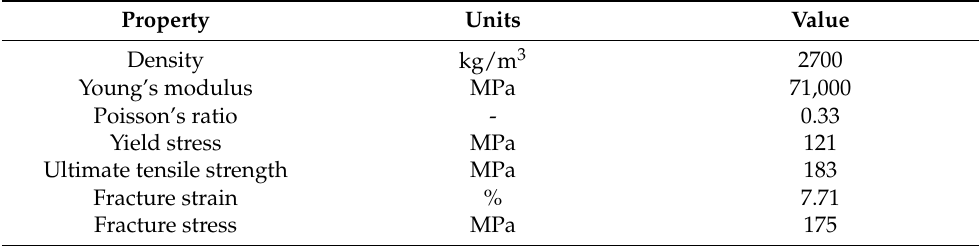
Table 1. Material parameters of multi-cell